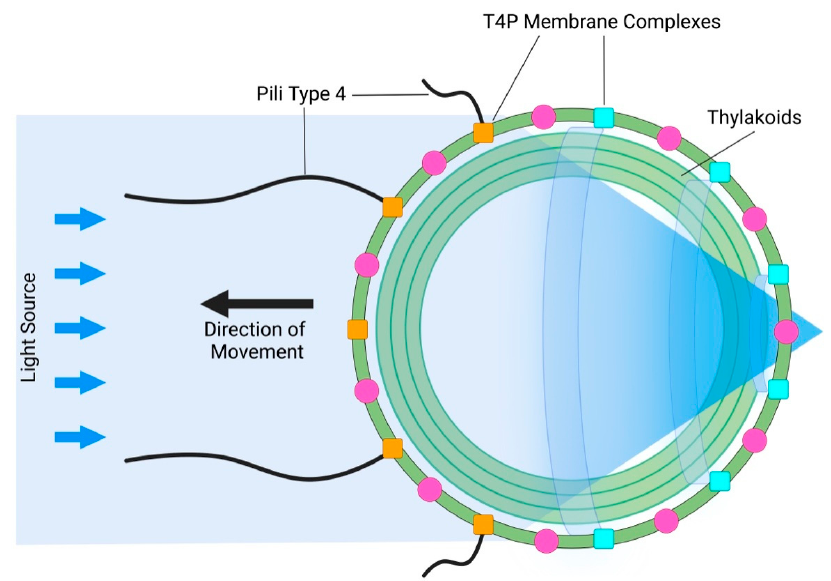
Figure 3. Bacterial Vision: Cyanobacterium Synechocystis. The whole cyanobacterial cell acts as a lens, focusing light beams on a small patch of the plasma membrane which controls the type-IV pili-based motility apparatus anchored in the plasma membrane via T4P complexes. Under the plasma membrane are thylakoid membranes. This model was adapted according to [43].